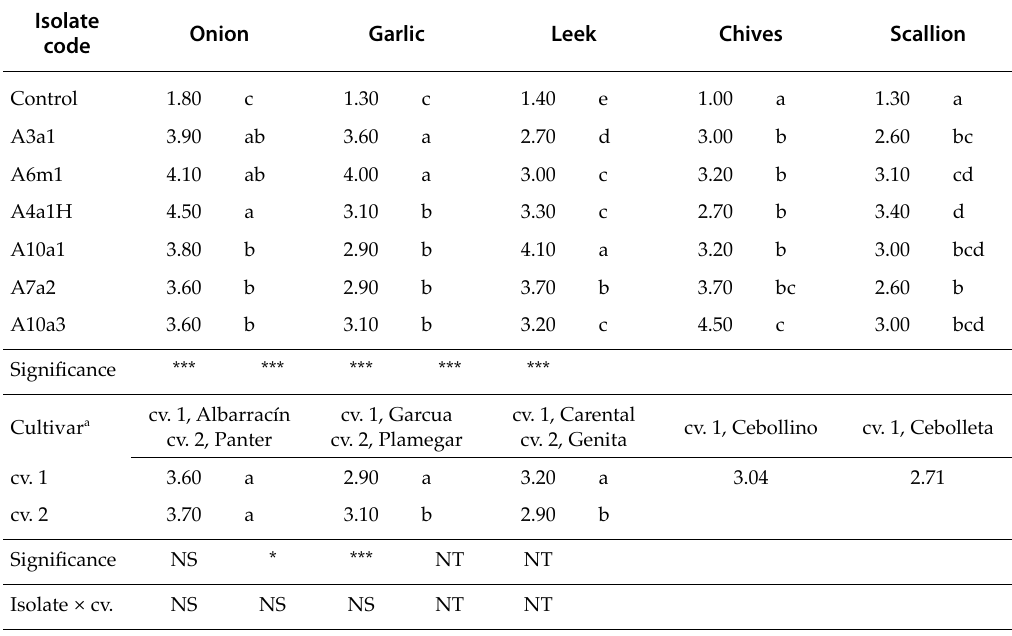
Table 2. Disease severity index (Dsi) on onion ( Allium cepa ), garlic ( A. sativum ), leek ( A. porrum ), chives ( A. schoenoprasum) and scallion ( A. fistulosum ) seedlings following artificial inoculation with isolates of F. proliferatum originating from garlic. Isolate Onion Garlic Leek Chives code